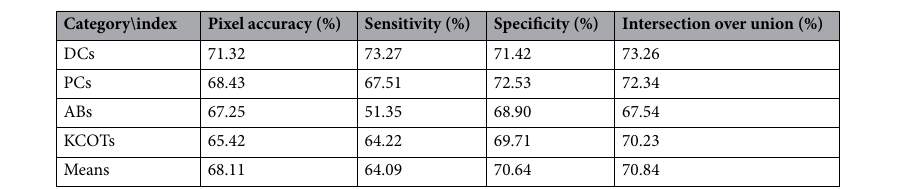
Table 3. The segmentation performance of different cysts and tumors. Cysts (DCs and PCs) have better segmentation performance than tumors (ABs and KCOTs).